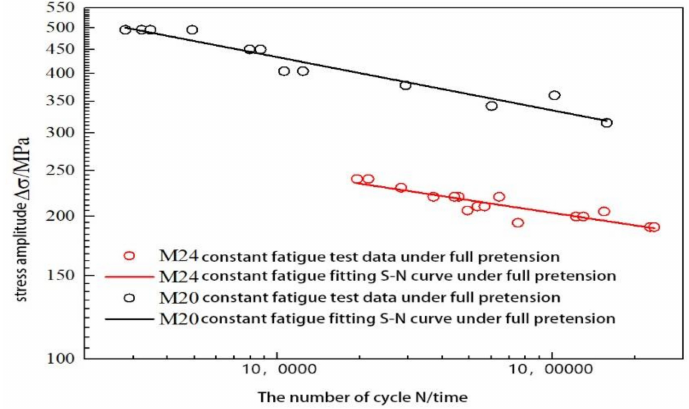
Figure 12. Comparison of fatigue test data of M24 and M20